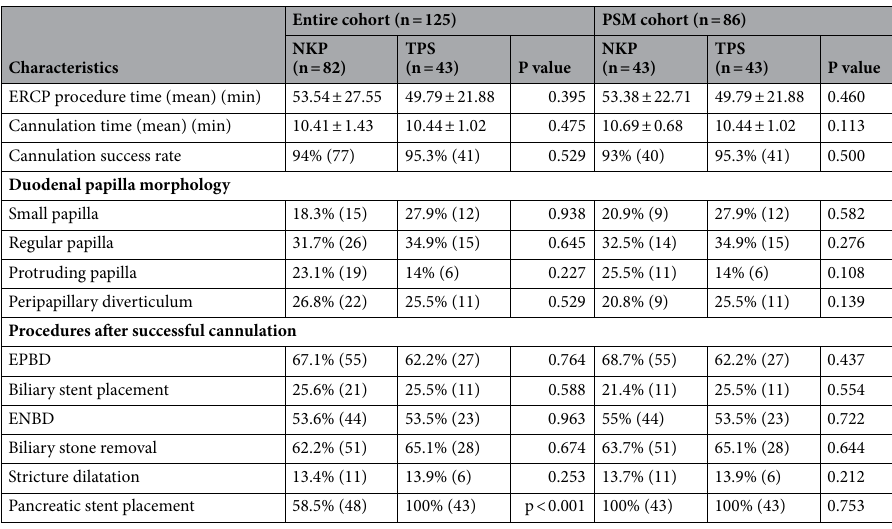
Table 2. Details of cannulation and procedures after successful cannulation in the total cohort and PSM- matched groups. EPBD endoscopic sphincterotomy with balloon dilation, ENBD endoscopic nasobiliary drainage.